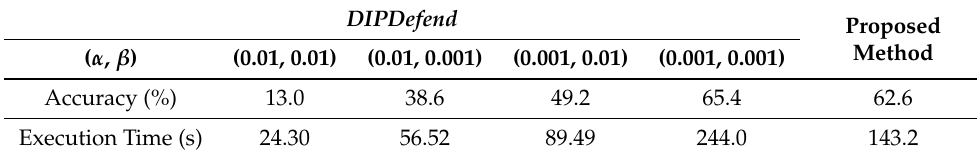
Table 12. Execution time and accuracy of DIPDefend and the proposed method when (cid:101) = 2.